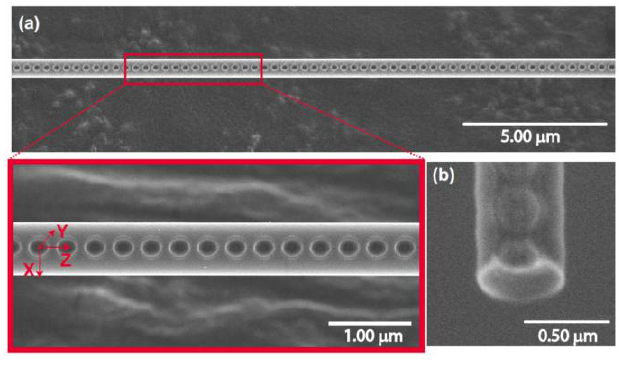
Figure 17. ( a ) Scanning electron microscope image of a structured nanofiber fabricated using single-shot irradiation of the ONF by a femtosecond laser beam. Inset: Enlarged view. Periodic nanocrater structures are observed on the shadow side of the nanofiber. ( b ) Cross-sectional image of a nanocrater measured by tilting the nanofiber. Reprinted with permission from [141]. Copyright 2013 Optical Society of